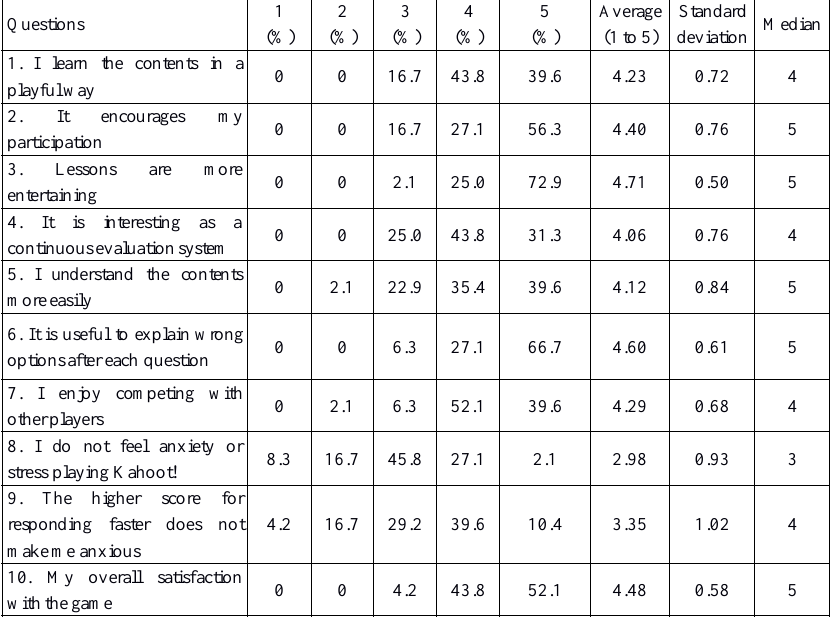
Table 1. Questionnaire data analysis